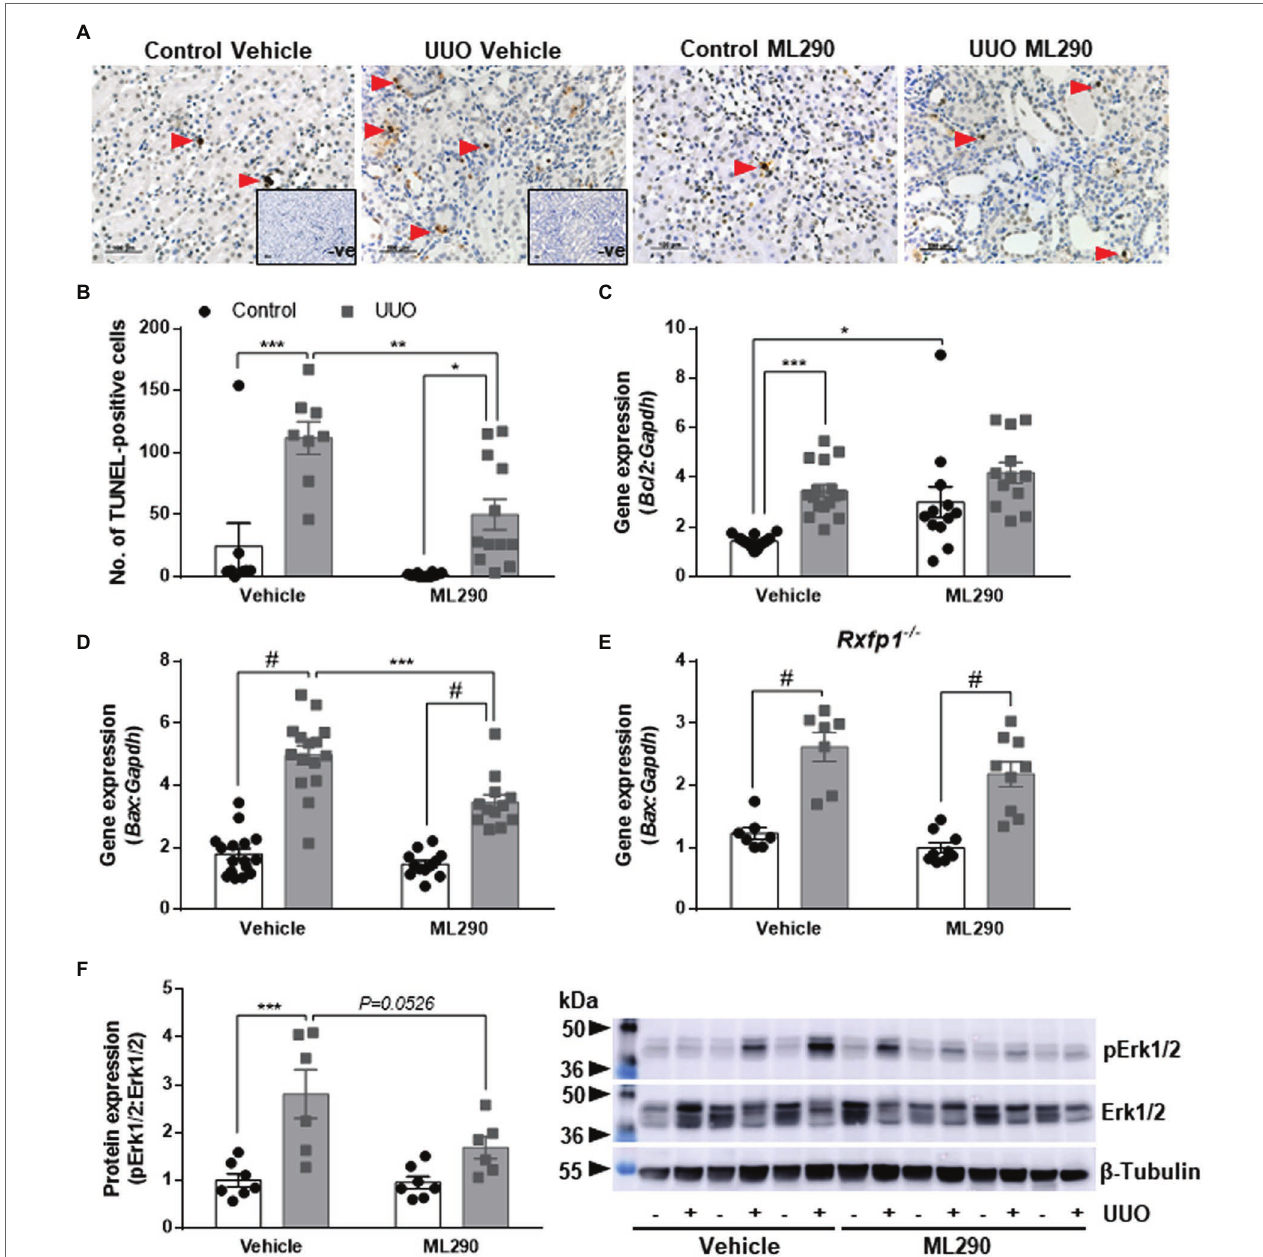
FIGURE 1 | (A) : Representative images of TUNEL staining. Red arrows indicate specific staining for apoptotic cells. There was no positive brown staining in negative control (without TdT enzyme; inset ). Scale bar = 100 μ m. (B) : Quantitative analysis of TUNEL-positive cells in the control and unilateral ureteral obstruction (UUO) kidneys from vehicle- and ML290-treated humanized mice ( n = 8–12 mice/group). (C–E) : Bcl2 (C) and Bax gene expression in the control and UUO kidneys from vehicle- and ML290-treated humanized (D) ( n = 12–16 mice/group) and Rxfp1 -deficient (E) ( n = 7–9 mice/group) mice. Gene expression is normalized to the housekeeping gene Gapdh and presented as fold change to control kidneys from vehicle-treated mice. (F) : Densitometric ratio of phospho-Erk1/2 (44, 42 kDa) to total Erk1/2 (44, 42 kDa) protein expression in the control and UUO kidneys from vehicle- and ML290-treated humanized mice ( n = 6–7 mice/group). β -tubulin (55 kDa) was used as the loading control. * p < 0.05, ** p < 0.01, *** p < 0.001, and # p <